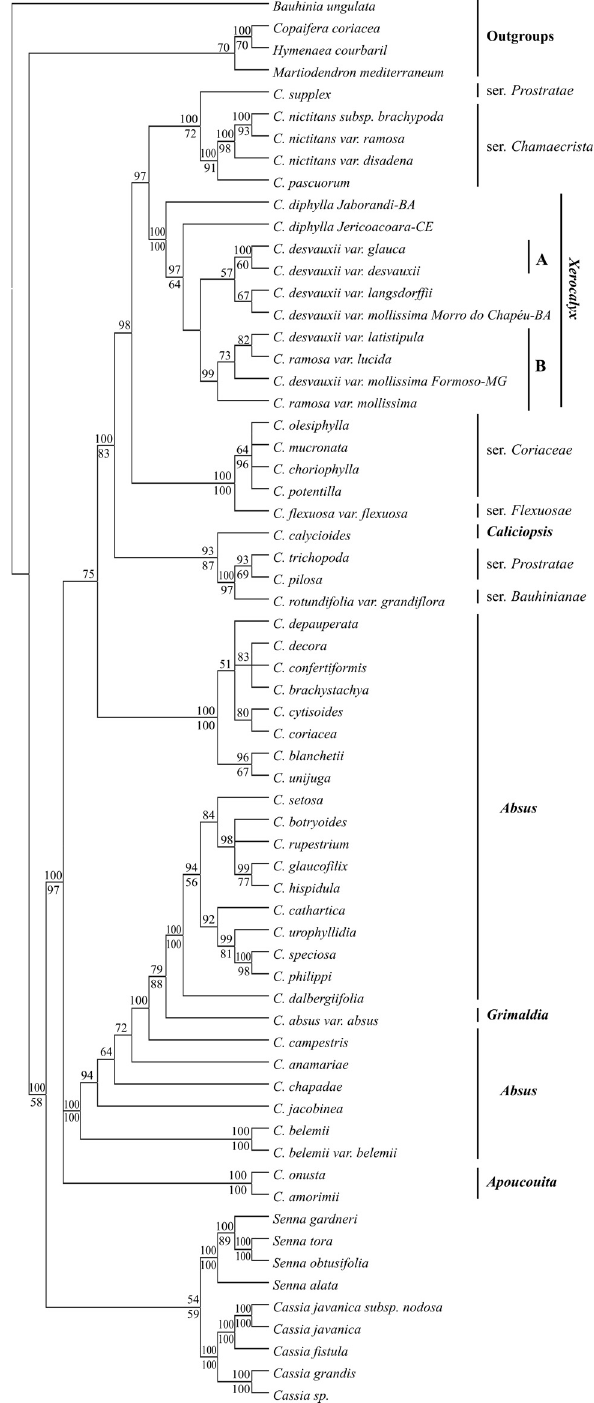
Figure 1 - Majority rule consensus tree based on the Bayesian analysis of the ITS/5.8S data set. Bauhinia ungulata , Copaifera coriacea , Hymenaea courbaril and Martiodendron mediterraneum were set as outgroups. Numbers above lines are Bayesian posterior probability values and below lines are bootstrap (1,000 replicates) support values from maximum parsi- mony analysis. Sections and series of Chamaecrista follow Irwin & Barneby (1982).